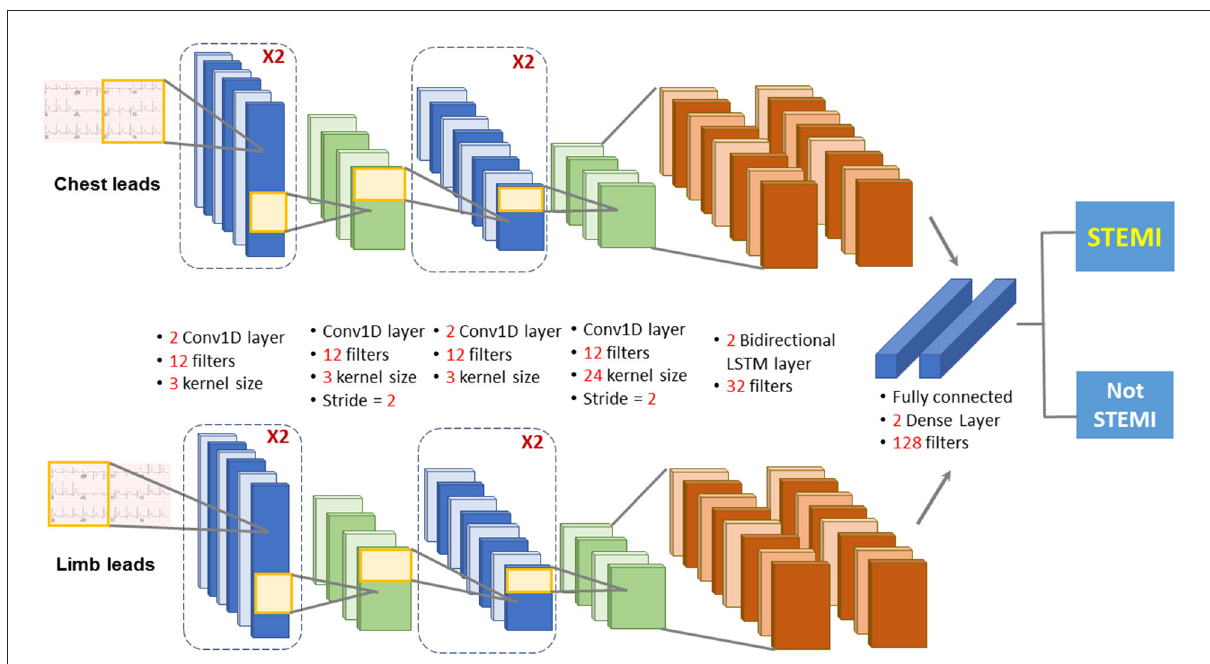
FIGURE2 Diagram depicting the deep learning model architecture. The deep learning model used a combination of CNN and LSTM to classify STEMI on 12-lead ECGs. The architecture of the proposed AI mode was composed of two 1D -CNNs blocks fed with chest and limb leads, to extract the features from the 6-lead signals. The outputs of the two 1D-CNNs were connected to two layers of LSTM, which served as a sequence analyzer. Then the outputs of the two LSTMs were concatenated and connected to a fully connected layer to classify the data as “STEMI” or “Not